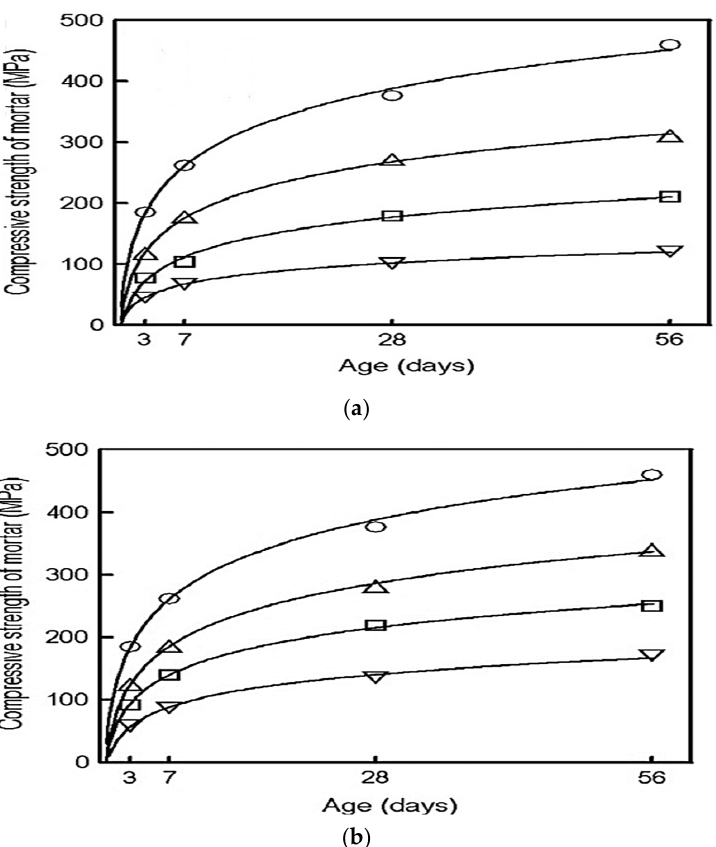
Figure 4. Influence of RCP on the compressive strength of mortar with RCP with ( a ) Blaine fineness of 928 cm 2 /g and ( b ) Blaine fineness of 1360 cm 2 /g (Note: ○ = reference mortar, △ = 15% RCP, □ = 30% RCP and ▽ = 45% RCP) [177].